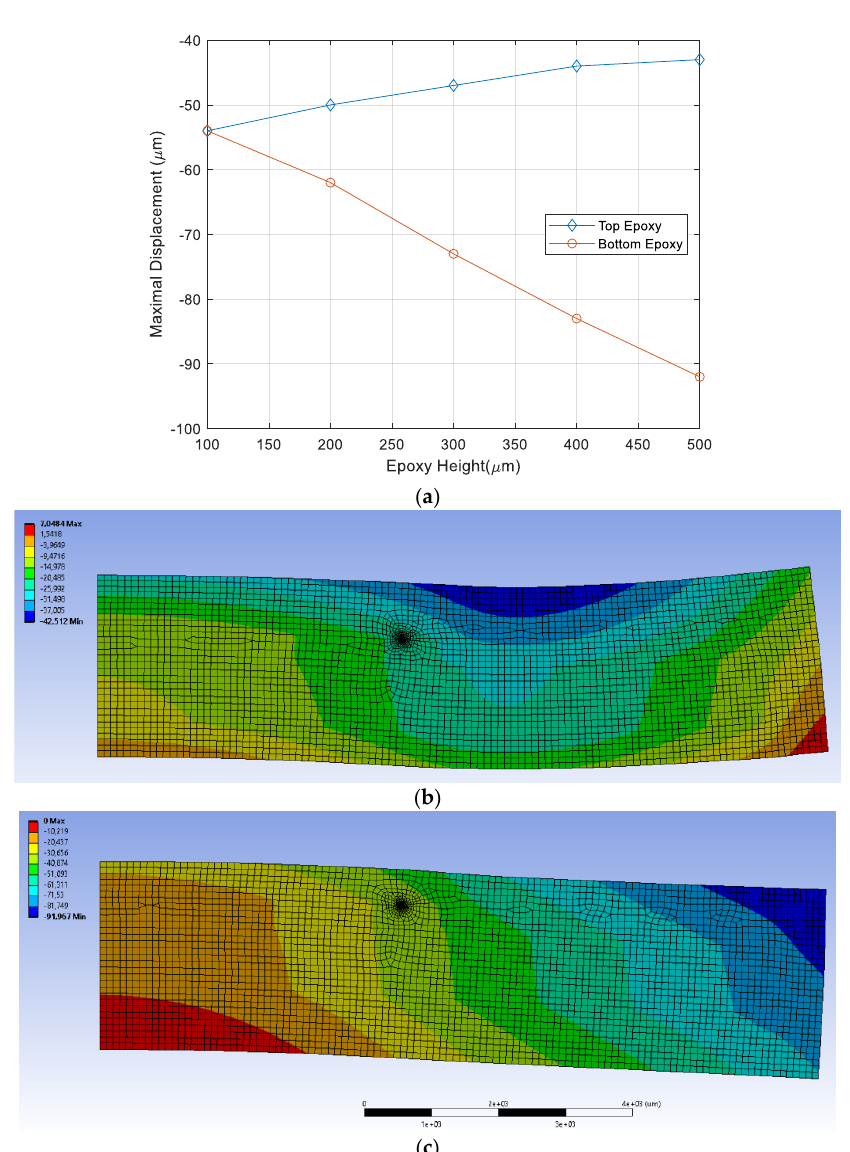
Figure 10. ( a ) Fracture parameters as function of top epoxy height. ( b ) Fracture parameters as function of bottom epoxy height.